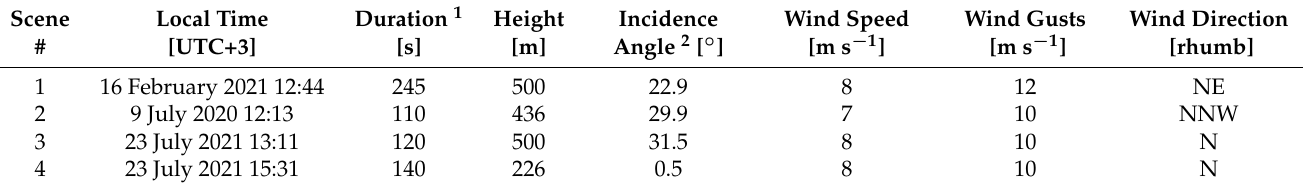
Table 1. Flight timetable, look geometry, and wind conditions reported by a local weather